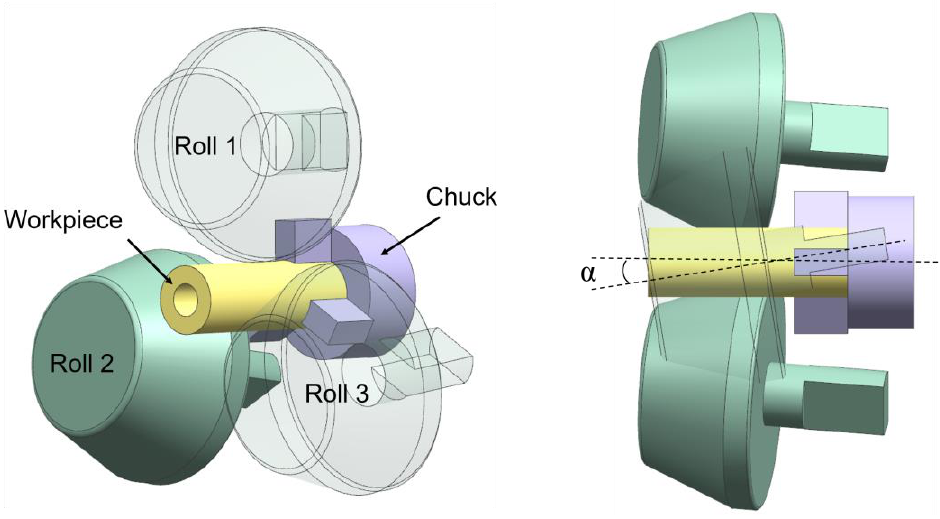
Figure 1. Finite element model.